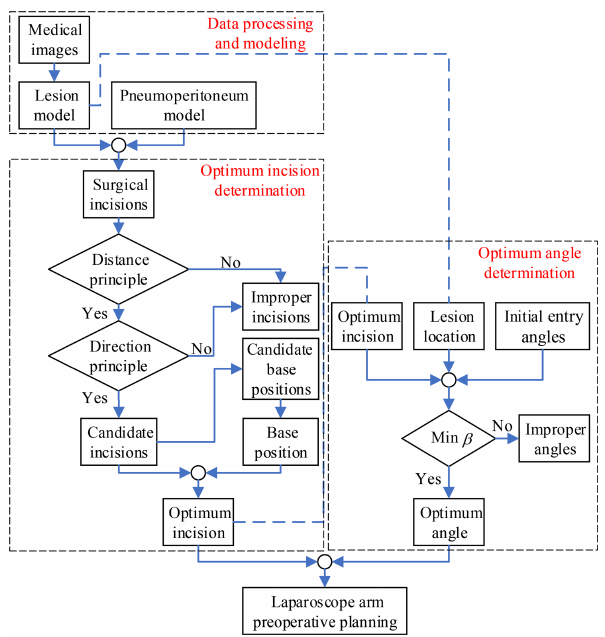
Figure 6. Flow chart of the laparoscope arm preoperative planning algorithm.